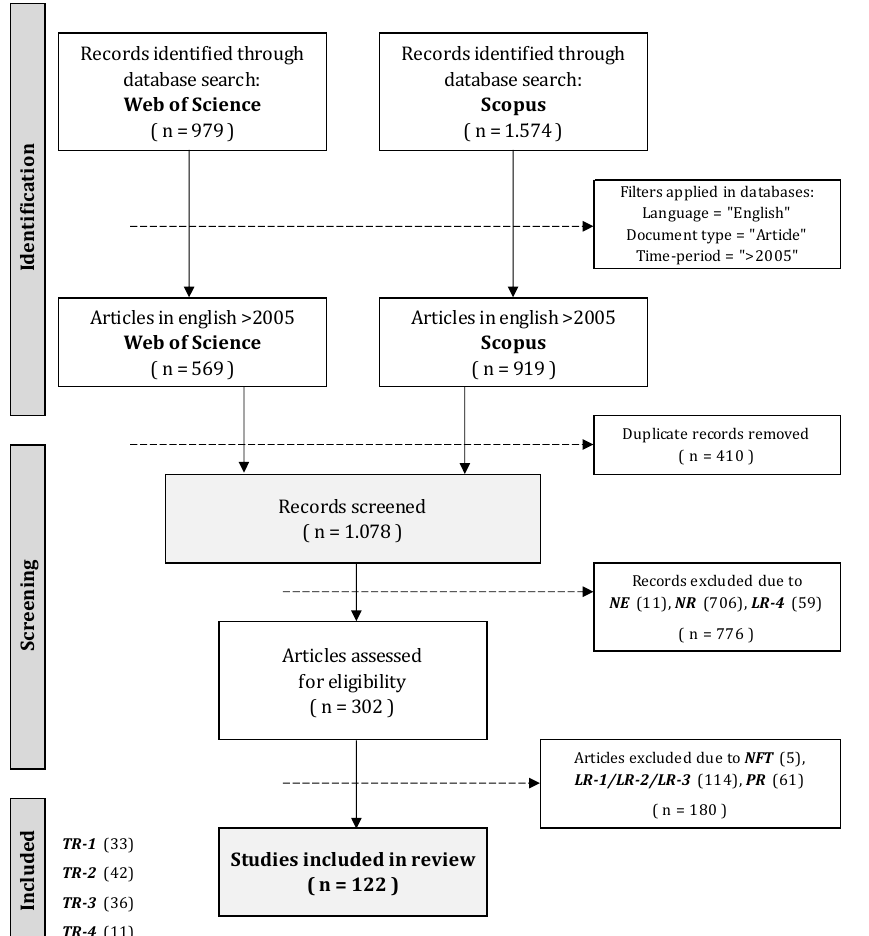
Figure 1. Search protocol (adapted from Page et al. 2021).